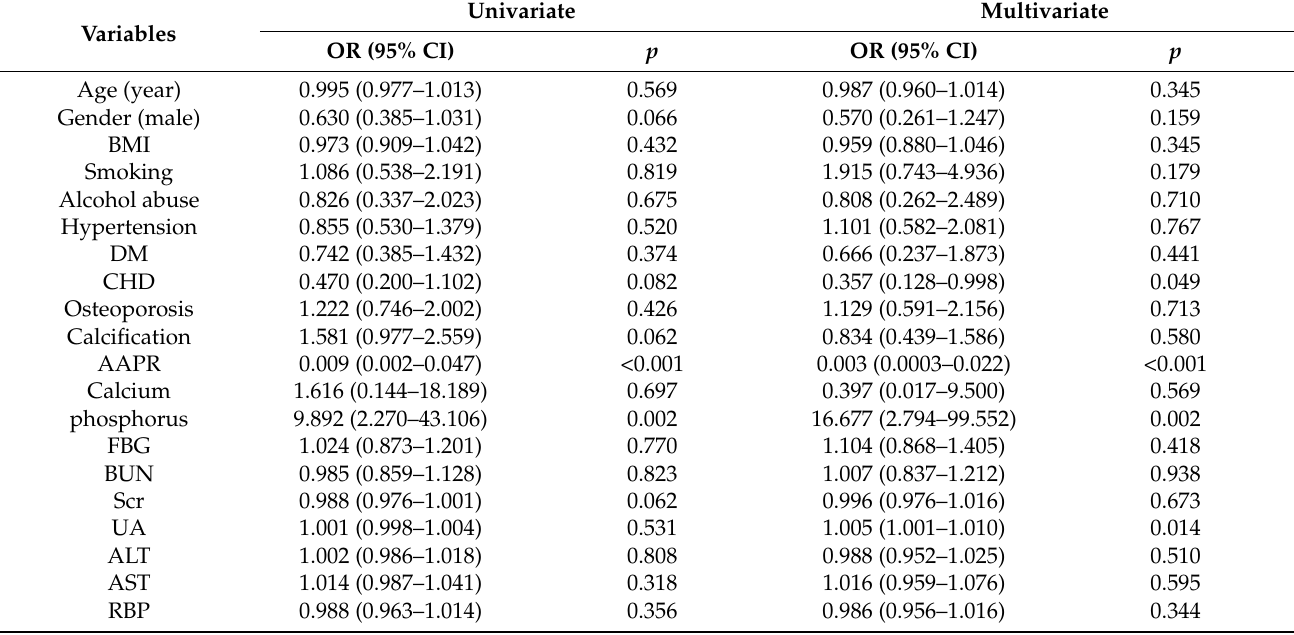
Table 7. Univariate and multivariate analysis model 2 of risk factors for